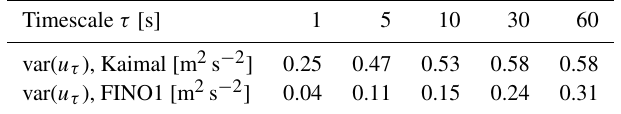
Table B1. Variances of each increment time series, u τ ( t ), for synthetic data based on the Kaimal model and field data.